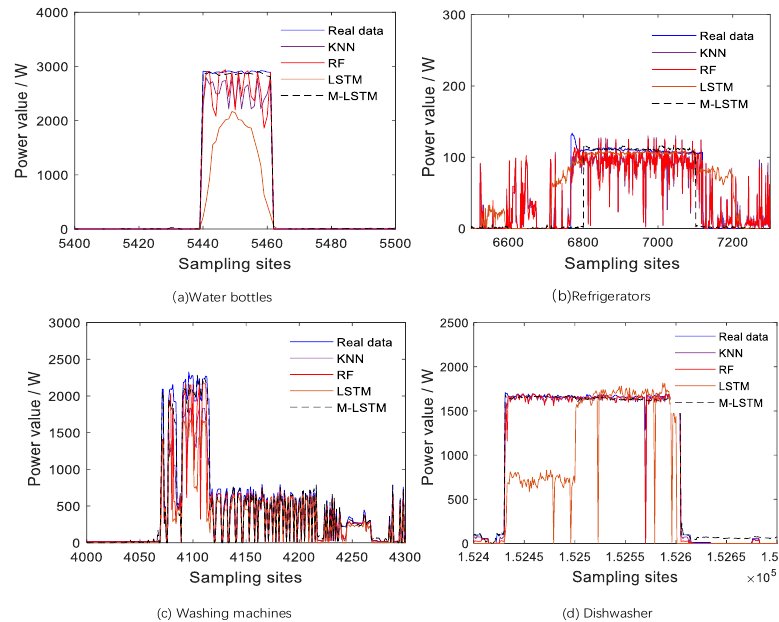
Figure 10. Comparison of local load decomposition for UK-DALE #5 homes.